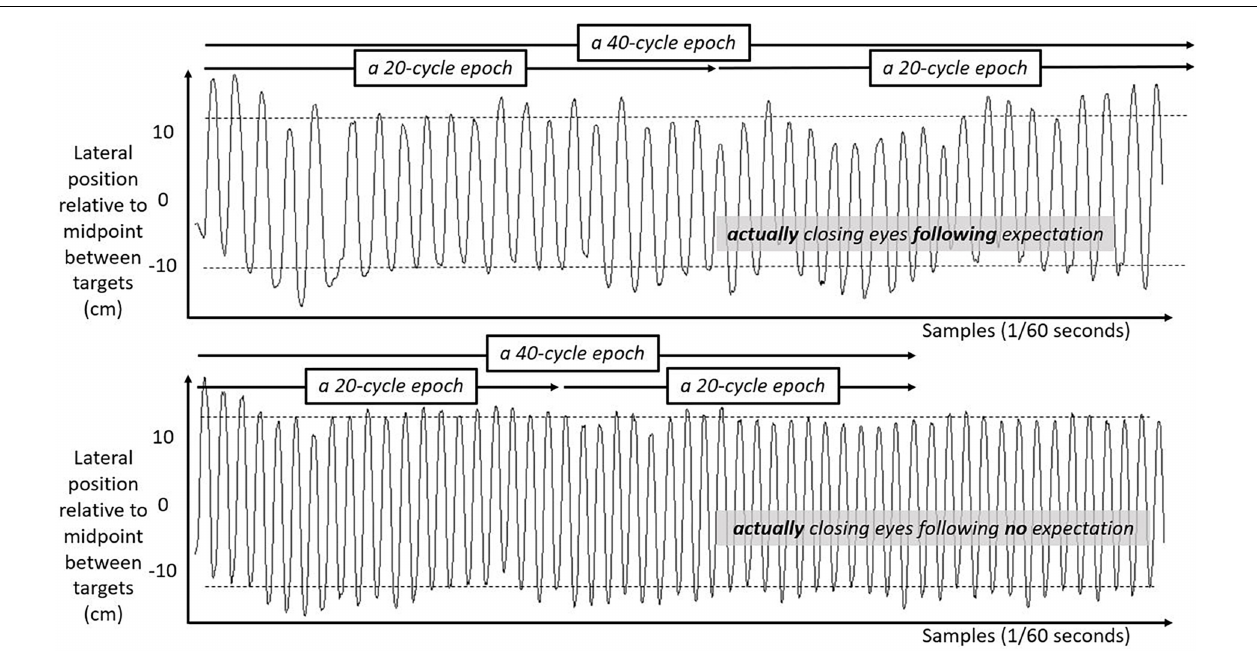
FIGURE 5 | Lateral hand position over time for 50 s in the second half of the task with eyes closed. Solid lines show the lateral position of the hand over time in the second half of the task for two participants both with their eyes closed. Top panel shows movement series for a participant who had expected that they might have to close their eyes. Bottom panel shows movement series for a participant who had no expectation of having to close their eyes. Dashed horizontal lines schematize the average lateral position of manual contacts from which aiming variability SD(Aim) was